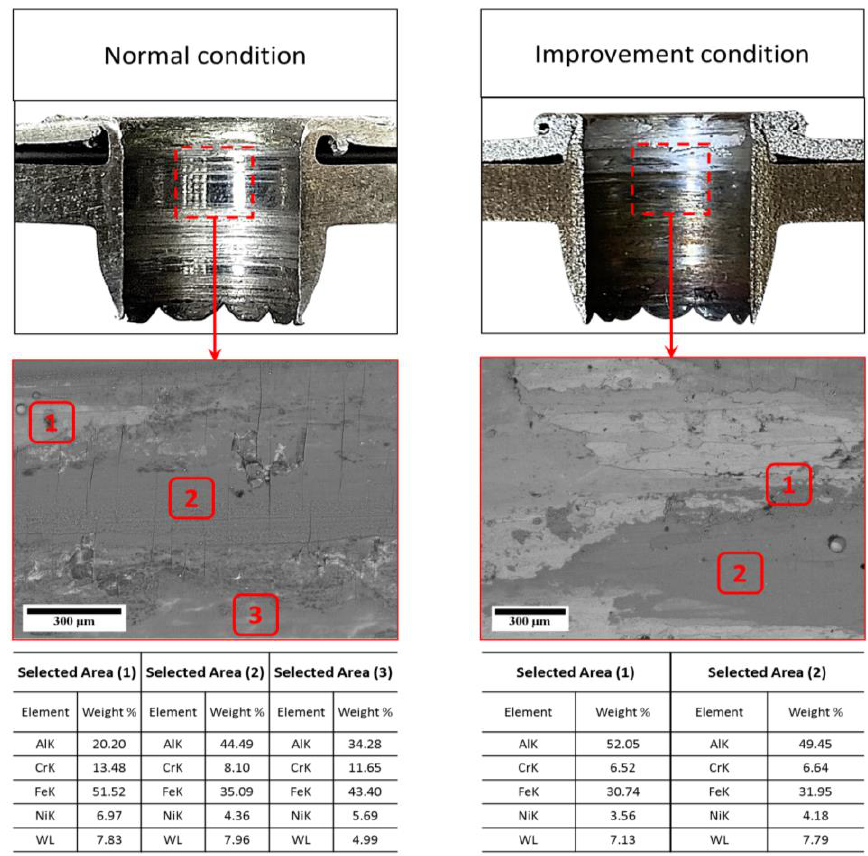
Figure 17. Cross-section and close-up views, and energy-dispersive X-ray analysis of center zones for friction drilled joints, under normal and improvement conditions.